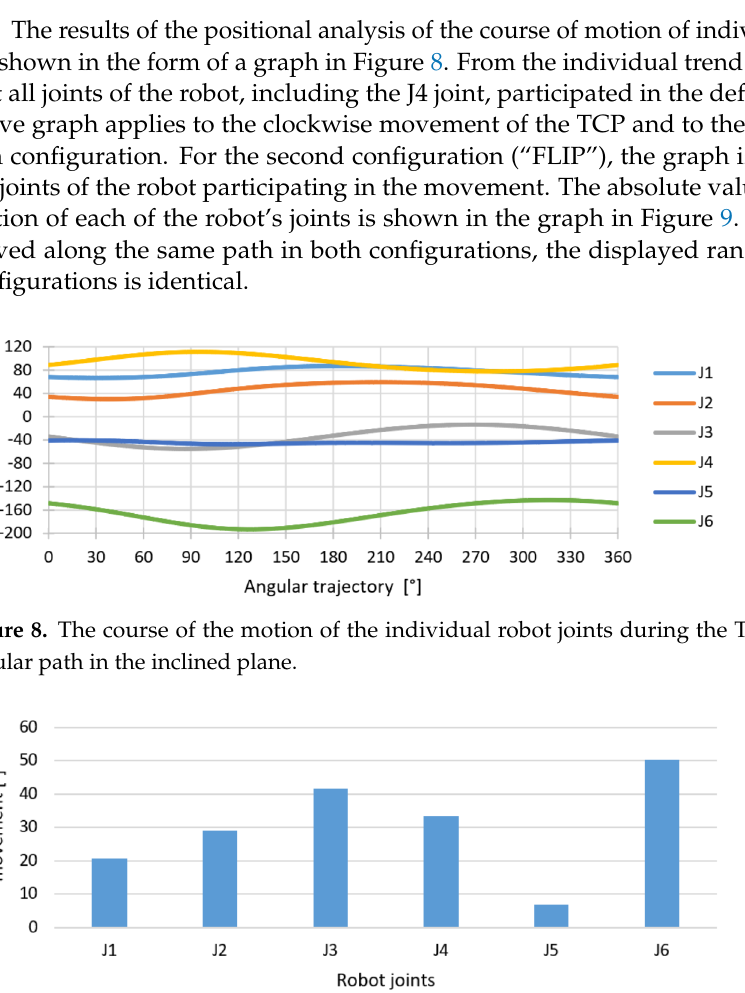
Figure 9. Absolute angular movement of robot joints during the movement along a circular path on the inclined